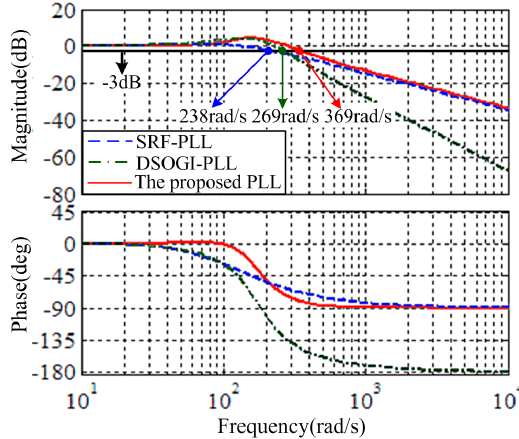
Figure 9. Closed-loop Bode plots of three kinds of PLL for h = 2.5.